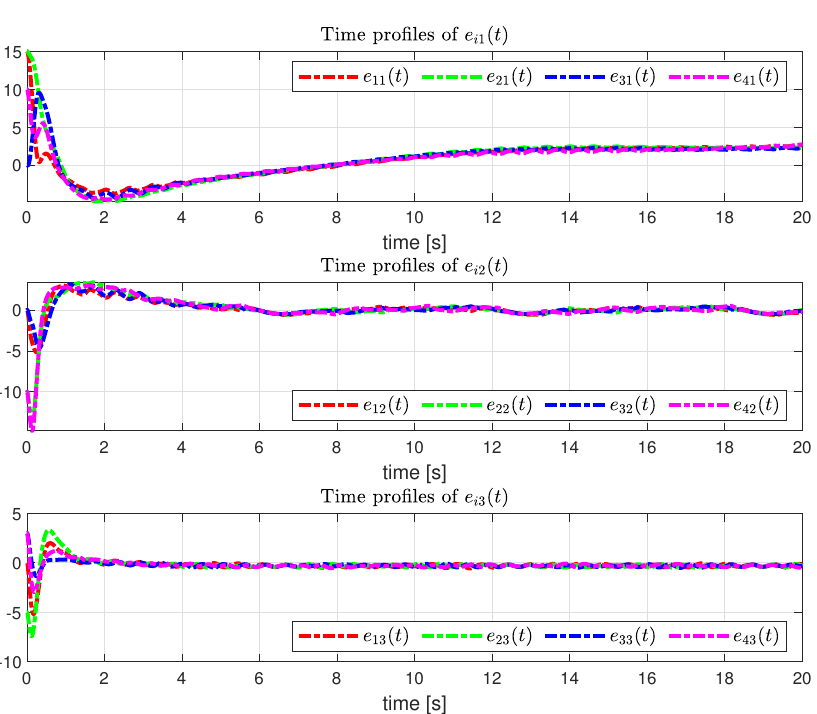
Figure 15. Performance of the robust internal model control law subject to velocity measurement noise with n V =